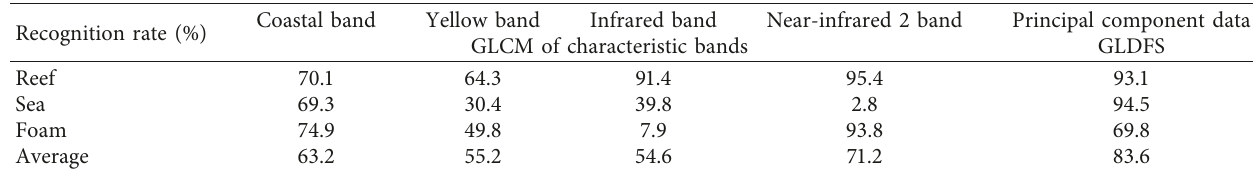
Table 2: The recognition rate of GLDFS and GLCM of characteristic